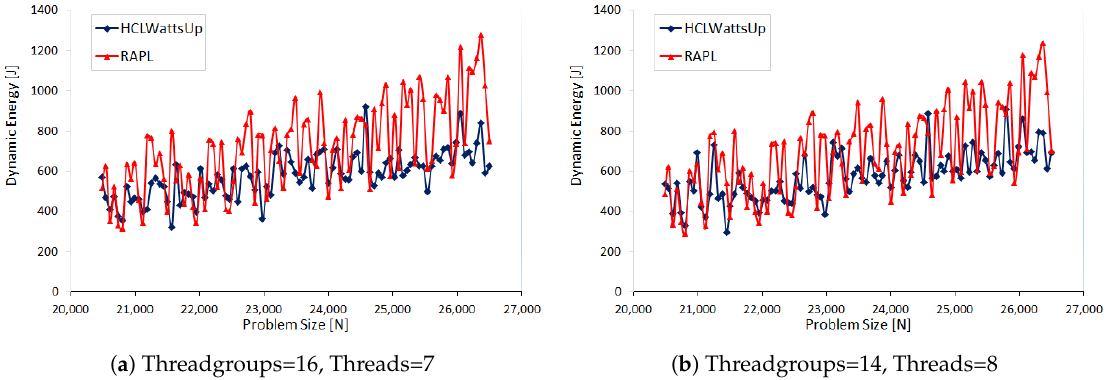
Figure 4. Dynamic energy profiles of FFTW (N = 20,480 − 26,560) by RAPL and HCLWattsUp on HCLServer03, class